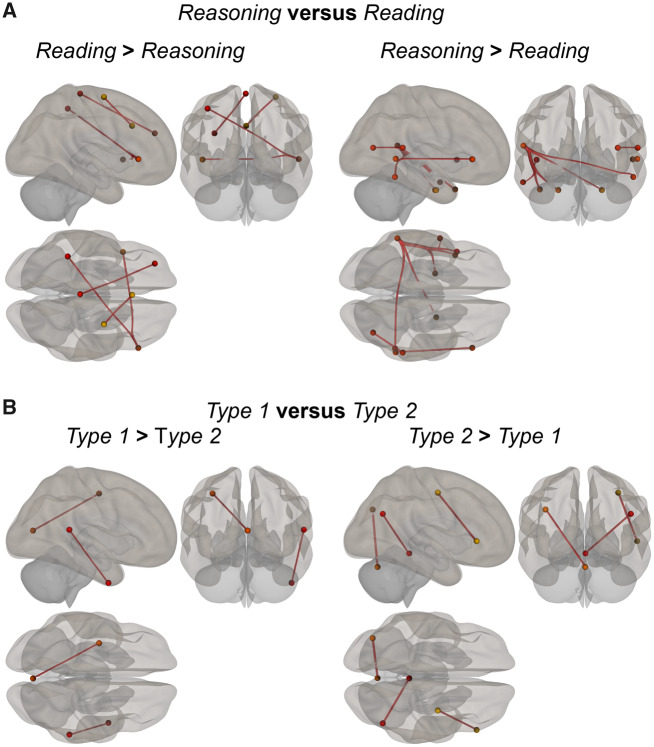

Connectivity differences. (A) Connections between regions which are significantly more involved reasoning compared with reading. (B) Connections between regions significantly involved in diagnosing the different types of cases.